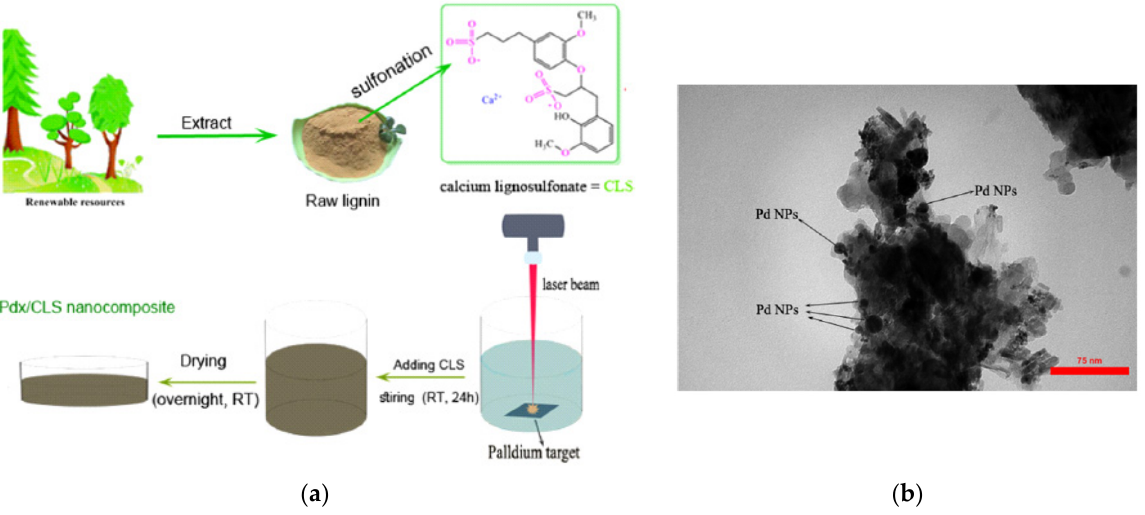
Figure 25. ( a ) Preparation of the lignosulfonate-supported palladium nanoparticles by laser ablation; ( b ) TEM image of the prepared catalyst used for depollution [161].